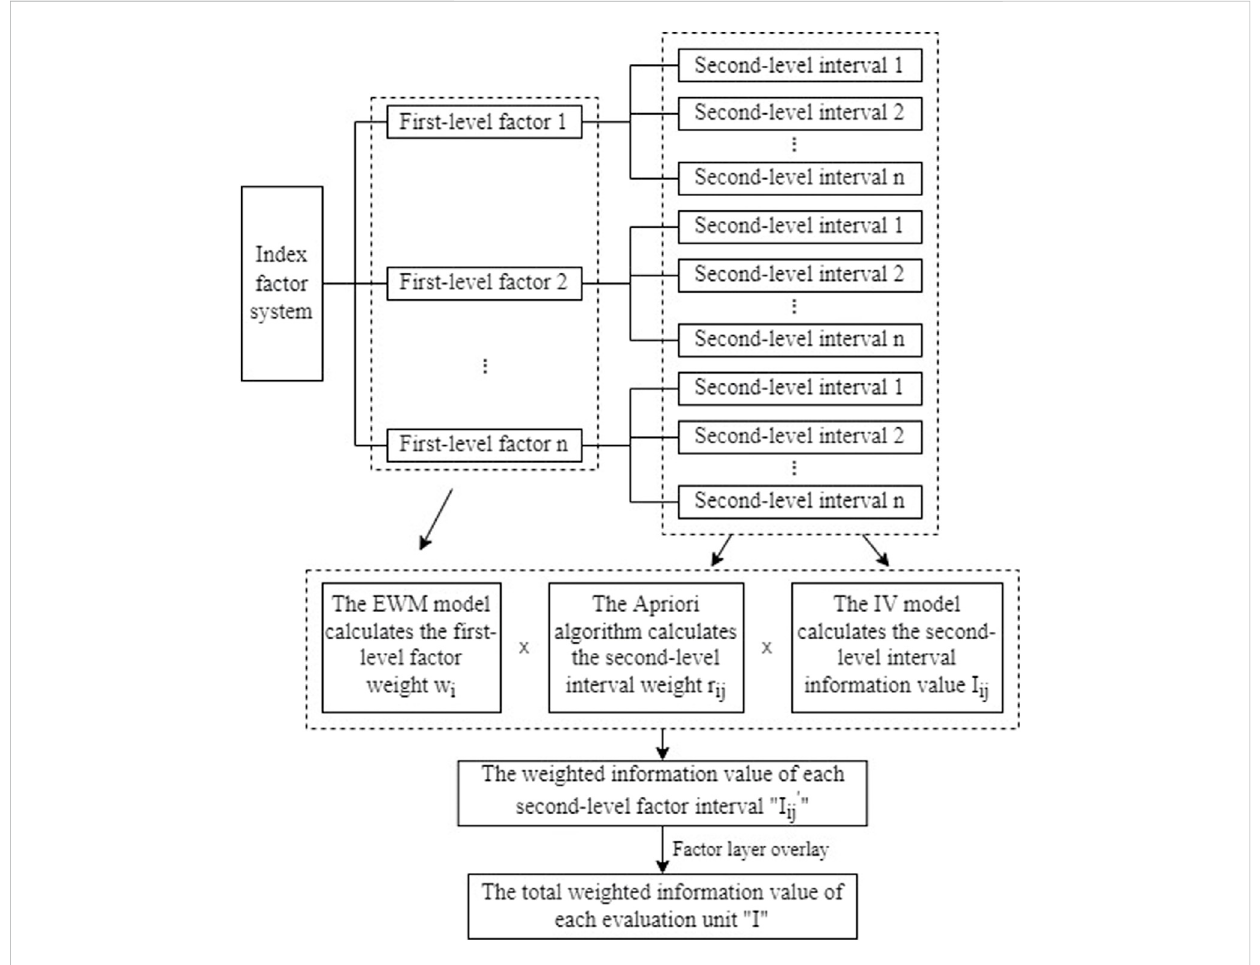
FIGURE 3 Calculation fl owchart of EWM-Apriori-IV